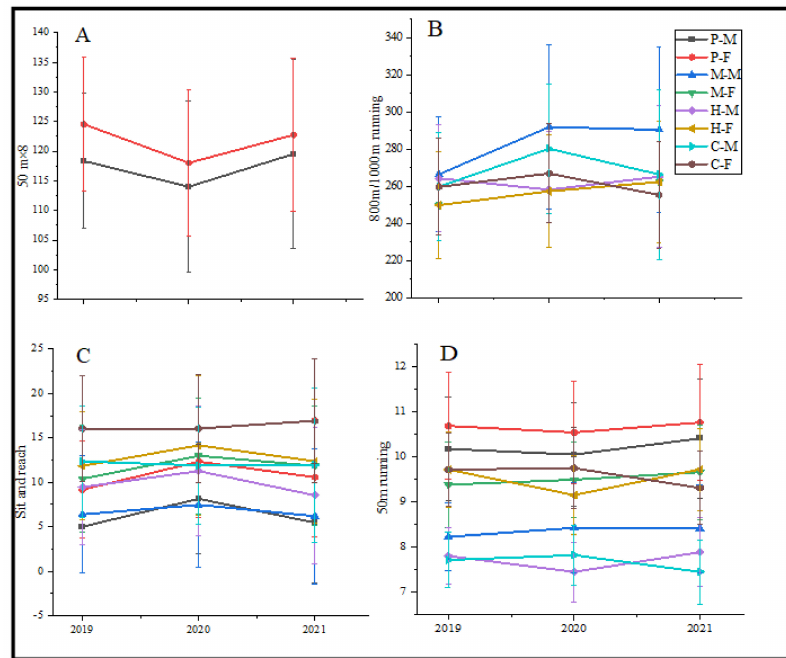
Figure 3. The trend of 50 m × 8, 800/1000 m running, Sit and reach, 50 m running. ( A ) The trend of 50 m × 8; ( B ) The trend of 800 m/1000 m; ( C ) The trend of sit and reach; ( D ) The trend of 50